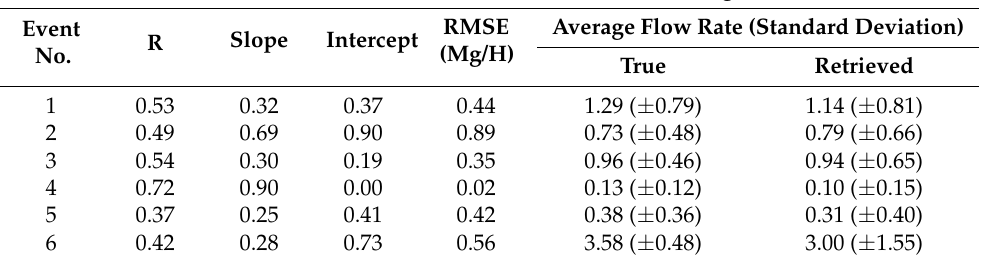
Table 5. LRT-SO 2 flow rate uncertainties under the conditions of errors in both wind data and GEMS SO 2